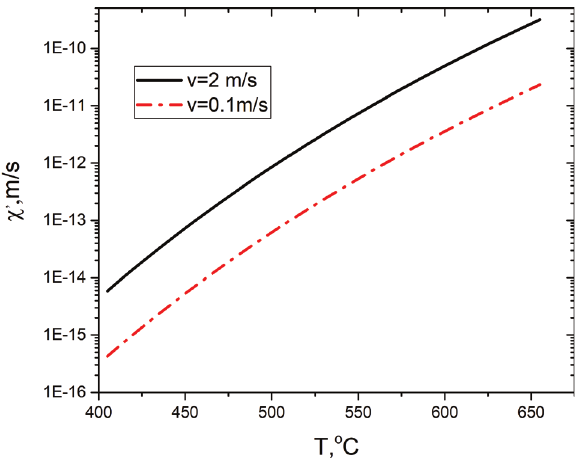
Figure 2. Empirical dependences of parabolic constants for var- ious types of steels (Zhang and Li 2007; Hwang and Lim 2010).